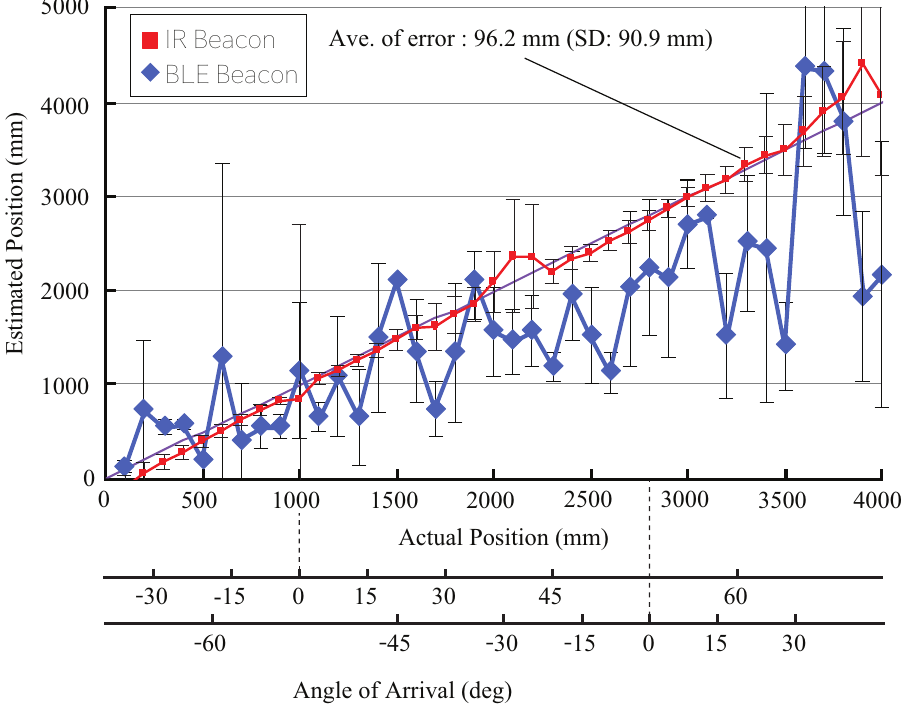
Figure 5. Comparison of positioning performance using a single beacon (the two receivers were installed on the ceiling at distances of 1000 mm and 2800 mm).